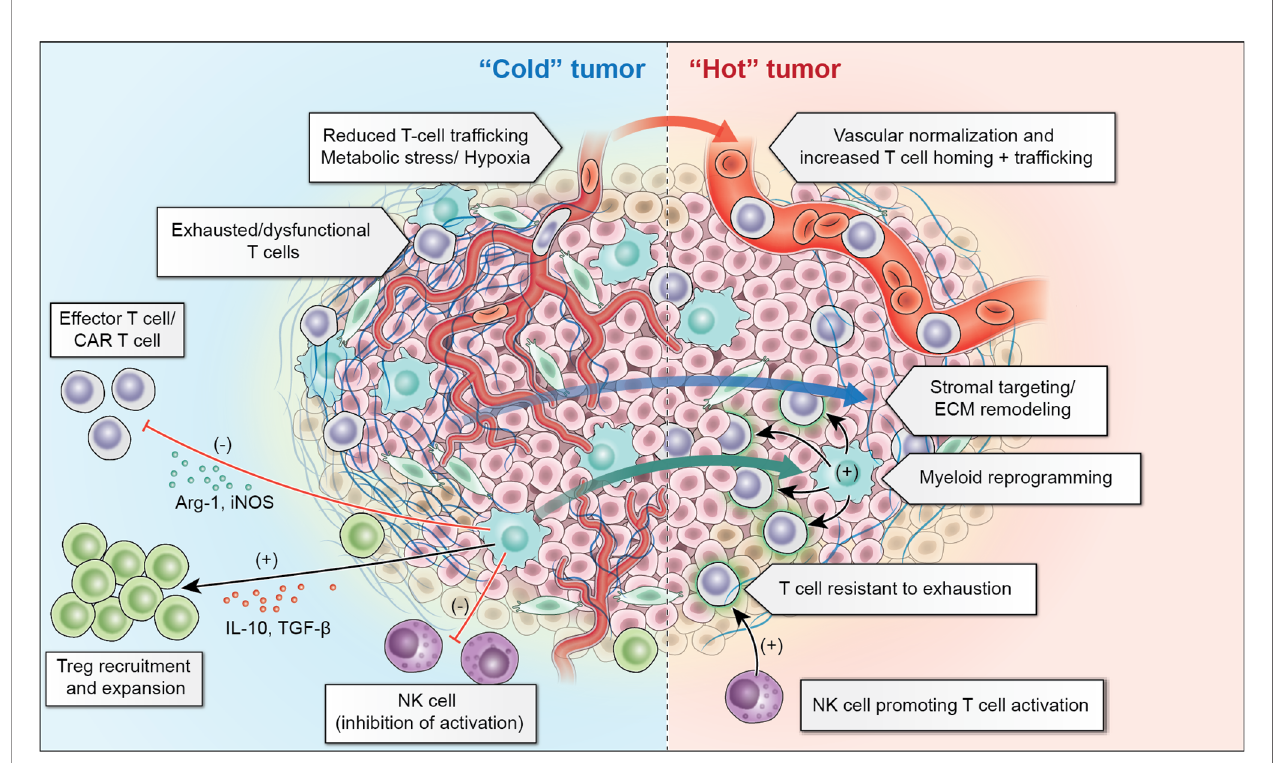
FIGURE 2 | “ Cold ” solid tumors present a number of challenges within their tumor microenvironment including reduced traf fi cking related to abnormal tumor vasculature and resident inhibitory myeloid cells which recruit regulatory T cells (Treg) and lead to exhaustion of T-cells and NK-cells. Adoptive cellular therapies aim to overcome these challenges through vascular normalization and extracellular matrix (ECM) remodeling to promote improved traf fi cking, as well as myeloid cell reprogramming to diminish the inhibitory contribution of these cells. Additionally, T-cells which are resistant to inhibition or “ armored ” T-cells, or NK-cells which can augment T-cell responses may make it possible to overcome the inhibitory tumor